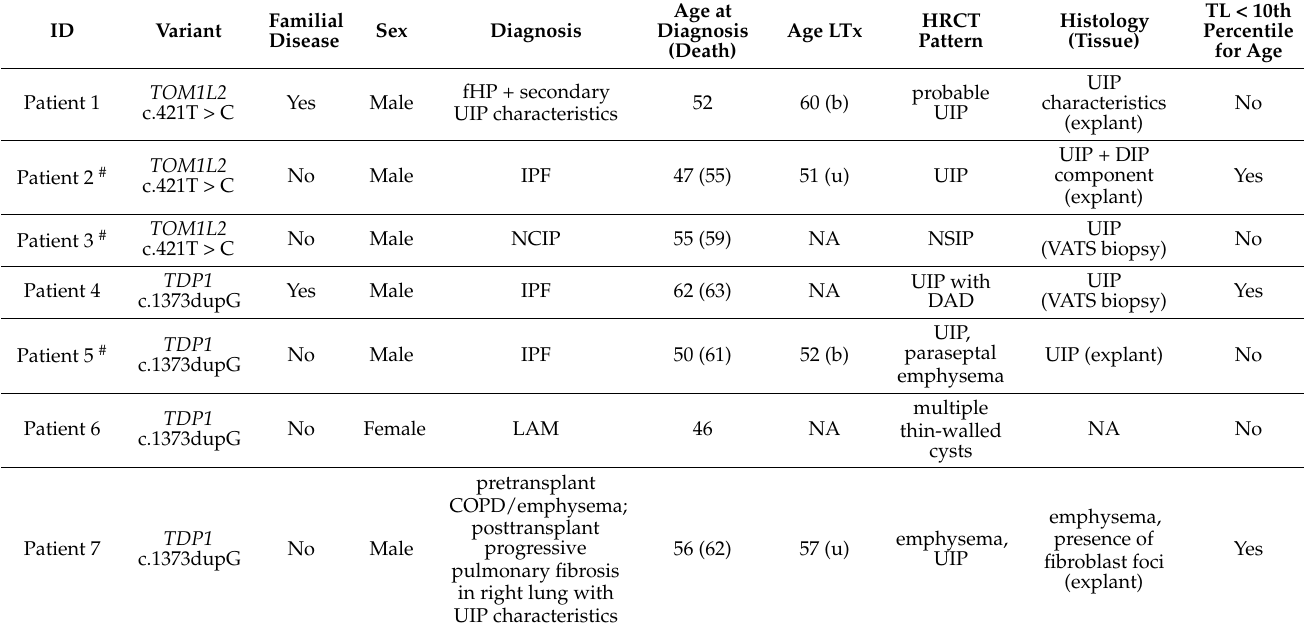
Clinical characteristics of TOM1L2 c.421T > C or TDP1 c.1373dupG